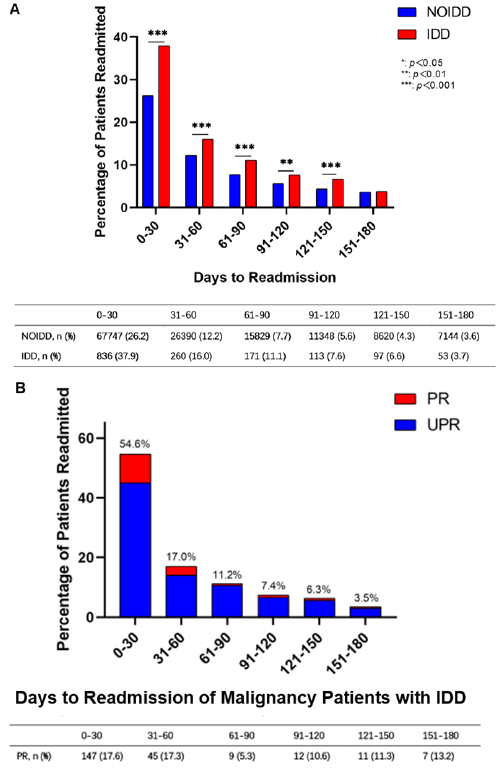
Figure 2. Malignancy patients’ (with IDDs and without IDDs (NOIDDs)) distribution of readmission to hospital during the 180-day follow-up. ( A ) NOIDD and IDD distribution of readmission during the 180-day follow-up; ( B ) PR and UPR distribution of the readmission of malignant tumor patients with IDDs during the 180-day follow-up.